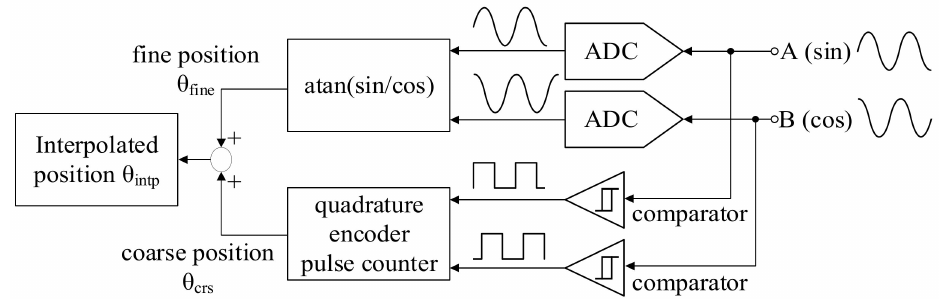
Figure 4. Encoder measurement improvement based on encoder pulse